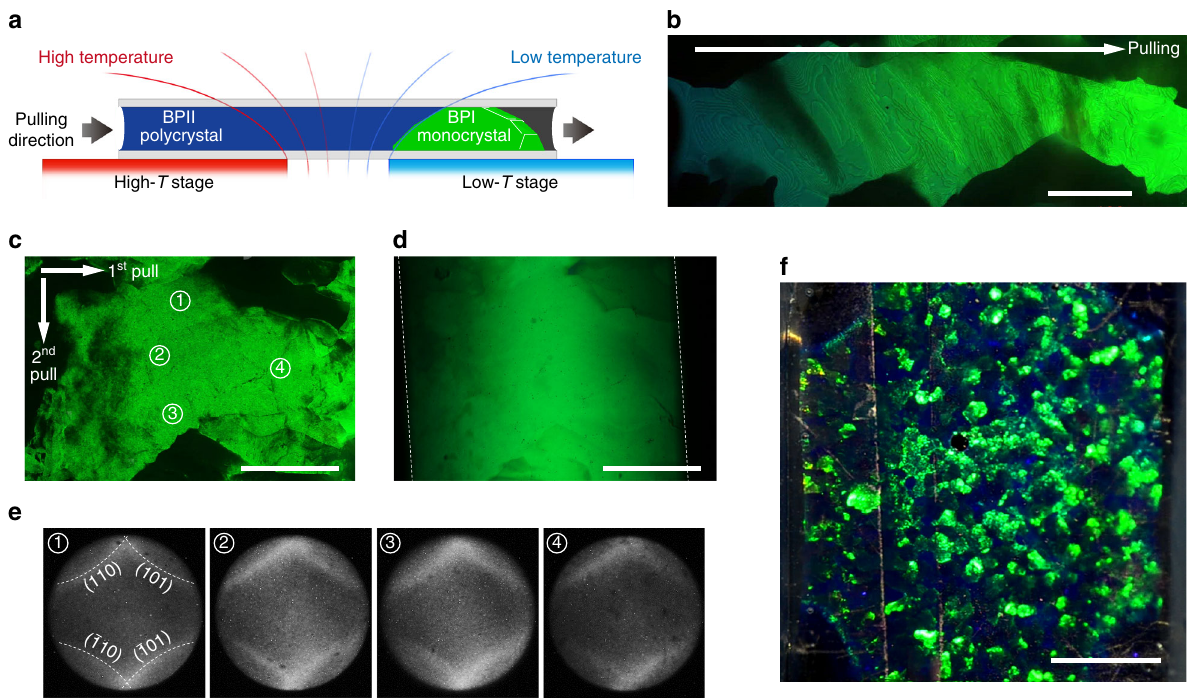
Fig. 3 Formation of large BPI single crystals by gradient-temperature scanning. a Schematic depiction of the GTS system. b Microscope image of a 3 mm-long BPI single crystal fabricated by 1D GTS (re fl ection; scale bar , 500 μ m). Microscope images of a 1.2 × 0.7 × 0.3 mm 3 -sized BPI monocrystal by 2D GTS in the c re fl ection and d transmission modes, respectively ( scale bars , 500 μ m). e Kössel diagrams captured at different labeled regions of the single crystal. f Macroscopic view of the sample with mm-sized BPI monocrystals (re fl ection; scale bar , 3 mm)